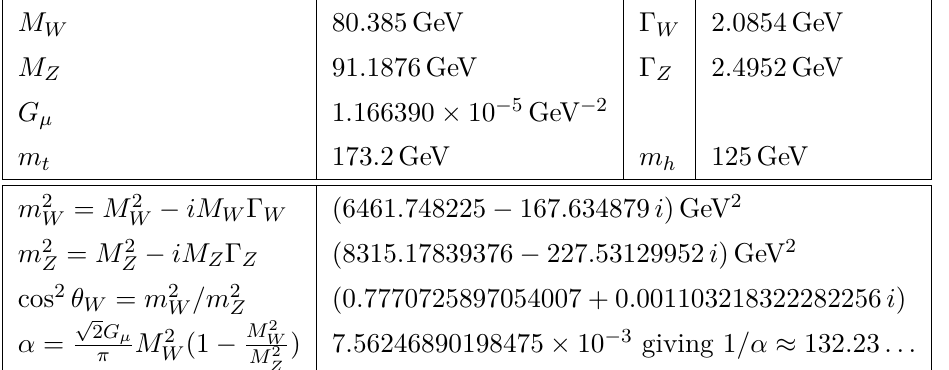
Table 2 . Input and derived parameters used for our numerical